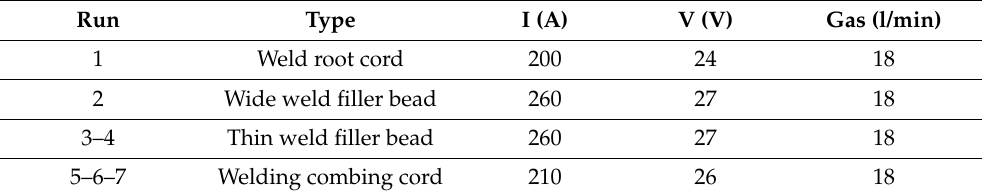
Table 5. Characteristics of the welds: type, current, voltage and gas flux. Run Type I (A) V (V) Gas (l/min) Weld root